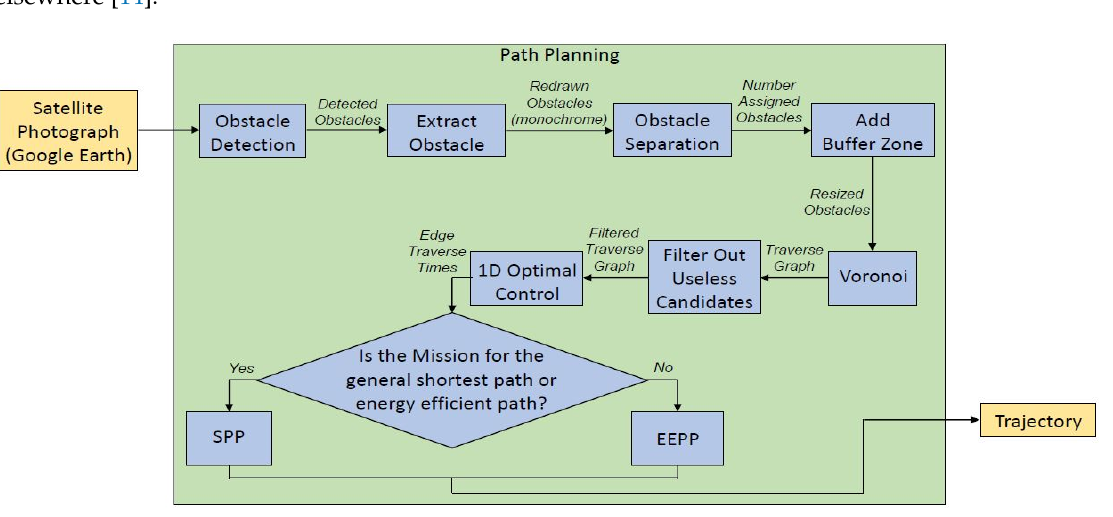
Figure 1. Mission hierarchy.